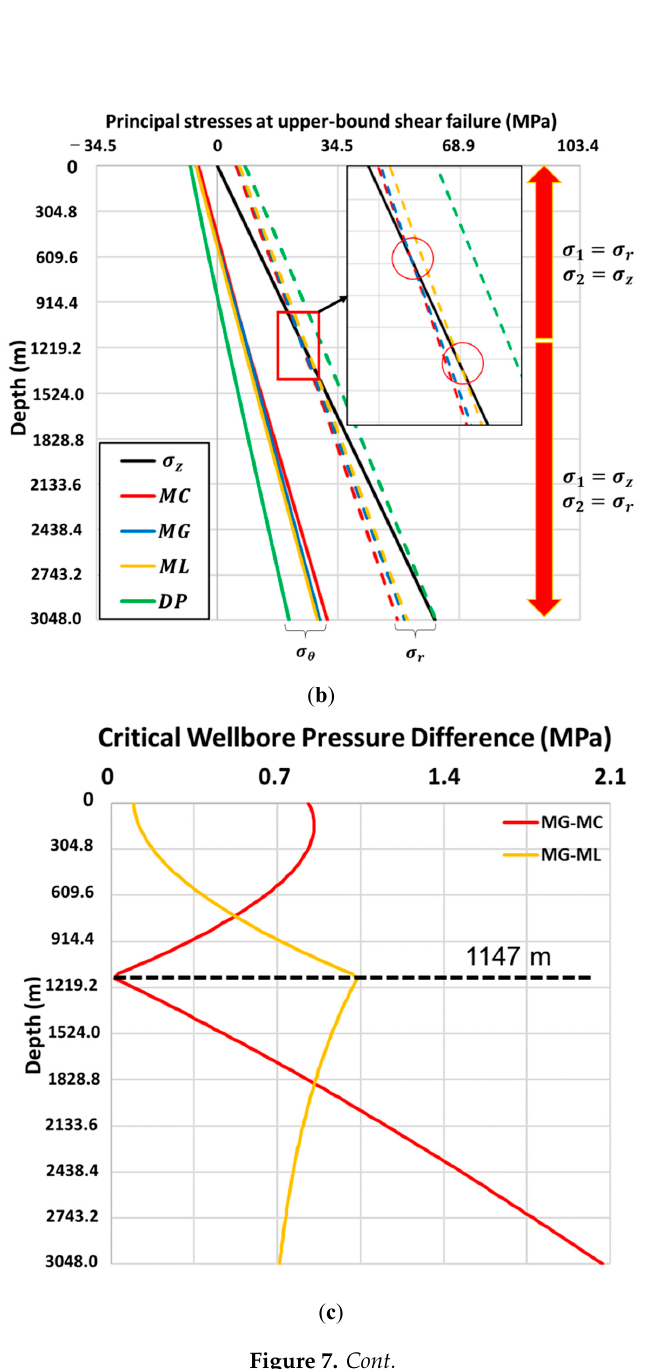
Figure 7. Figure 7. Normal faulting regime. Locally induced principal stresses at a moment of ( a ) lower-bound and ( b ) upper-bound shear failure under the normal faulting regime with the vertical, maximum and minimum horizontal stresses of 22.6, 20.4, and 15.8 kPa/m, respectively. The black solid lines represent the axial stress ( 𝜎 (cid:3053) ) . The tangential ( 𝜎 (cid:3087) ; solid) and radial ( 𝜎 (cid:3045) ; dashed) stresses are calculated by the Mohr–Coulomb (MC; red), Mogi–Coulomb (MG; blue), modified Lade (ML; yellow), and Drucker– Prager (DP; green) failure criteria. The magnified frame in (b) indicate reverse of the principal stress order. ( c ) Critical wellbore pressure difference at upper-bound shear failure. Difference between the Mohr–Coulomb (MC) and Mogi–Coulomb (MG), and the Mogi–Coulomb and modified Lade (ML) are shown in red and yellow curves, respectively. At 1147 m, the red curve reaches 0 and the yellow curve shows the maximum value.